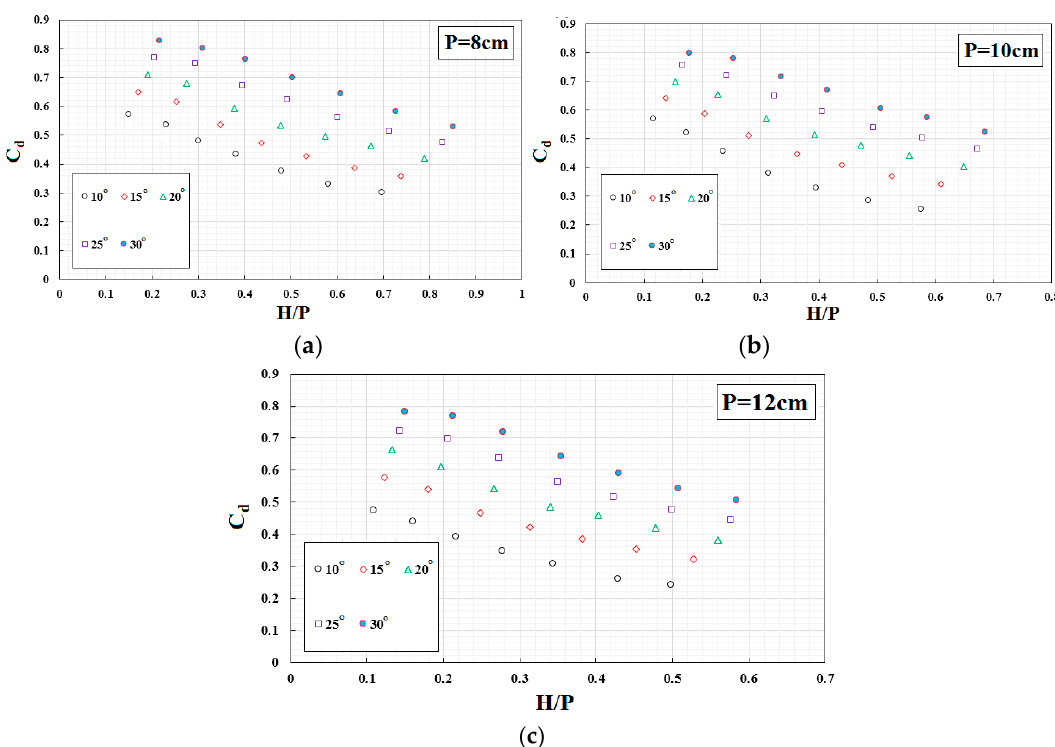
Figure 7. Experimental results obtained for the effects of weir geometry on variations of discharge coefficient C d versus H/P, ( a ) P = 8 cm, ( b ) P = 10 cm, ( c ) P = 12 cm.